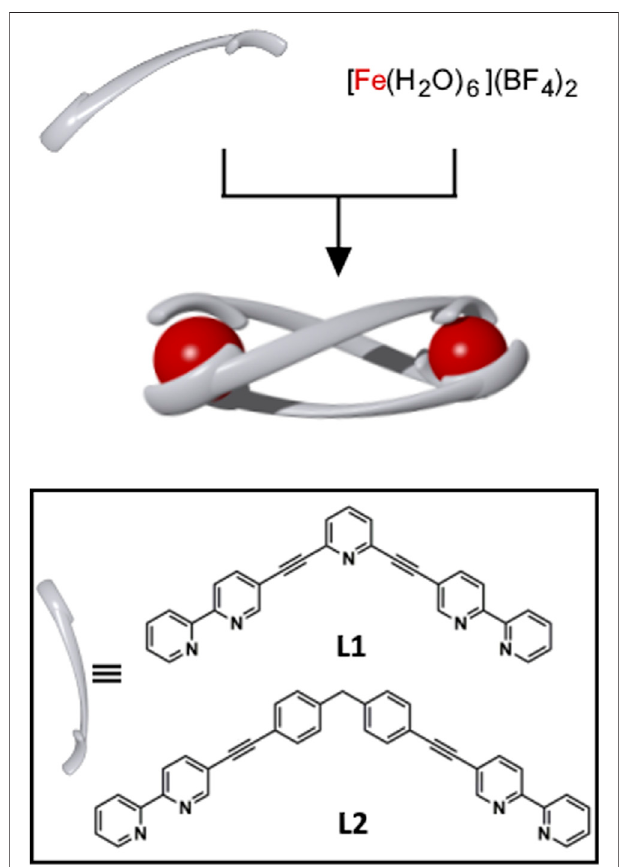
SCHEME 1 | Cartoon representation of the synthesis of the triply- stranded metallo-cylinders [Fe 2 ( L1 ) 3 ](BF 4 ) 4 and [Fe 2 ( L2 ) 3 ](BF 4 ) 4 . The complexes were synthesized by combining L1 or L2 (3 equiv.) with